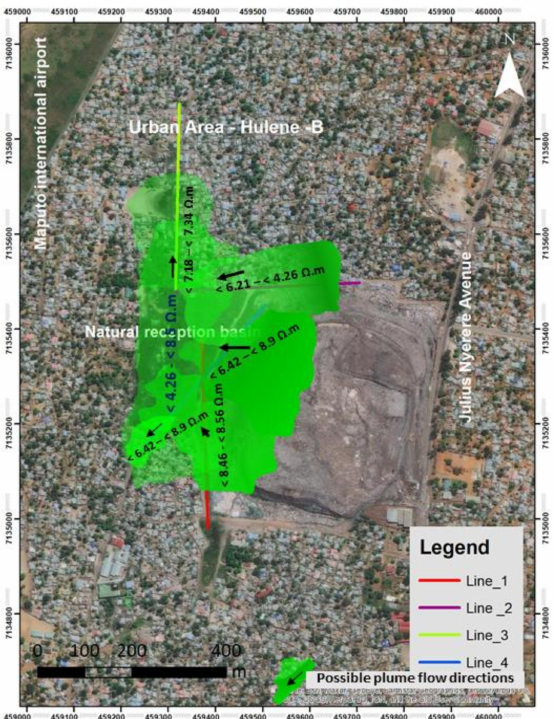
Figure 7. Possible flow directions of contamination plumes 2020–2021, modified from Bernardo et al.